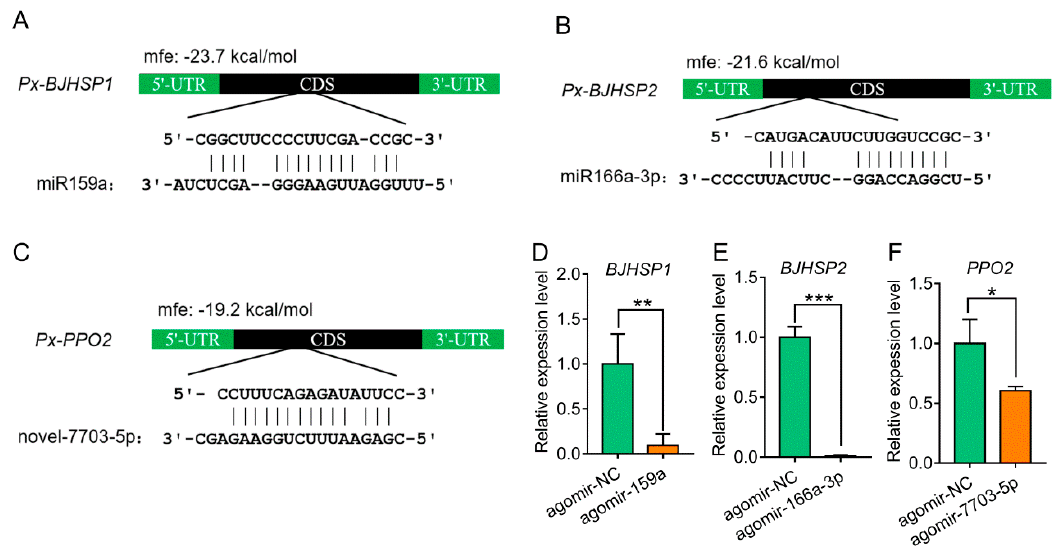
Figure 2. Prediction and validation of target genes of plant-derived miRNAs in P. xylostella . ( A – C ). Putative ( A – C ). Putative binding modes of miR159a and Px-BJHSP1 ( A ), miR166a-3p and Px-BJHSP2 ( B ), binding modes of miR159a and Px-BJHSP1 ( A ), miR166a-3p and Px-BJHSP2 ( B ), and novel-7703-5p and Px- and novel-7703-5p and Px-PPO2 ( C ) in CDS region. The mfe was indicated above the hybrid. ( D – F ). PPO2 ( C ) in CDS region. The mfe was indicated above the hybrid. ( D – F ). Relative expression levels of Px- Relative expression levels of Px-BJHSP1 , Px-BJHSP2 and Px-PPO2 at 24 h post-injection of corresponding BJHSP1 , Px-BJHSP2 and Px-PPO2 at 24 h post-injection of corresponding miRNA agomir. Data were miRNA agomir. Data were presented as mean ± SD (Student’s t test, * p < 0.05, ** p < 0.01, *** p < presented as mean ± SD (Student’s t test, * p < 0.05, ** p < 0.01, *** p < 0.001).